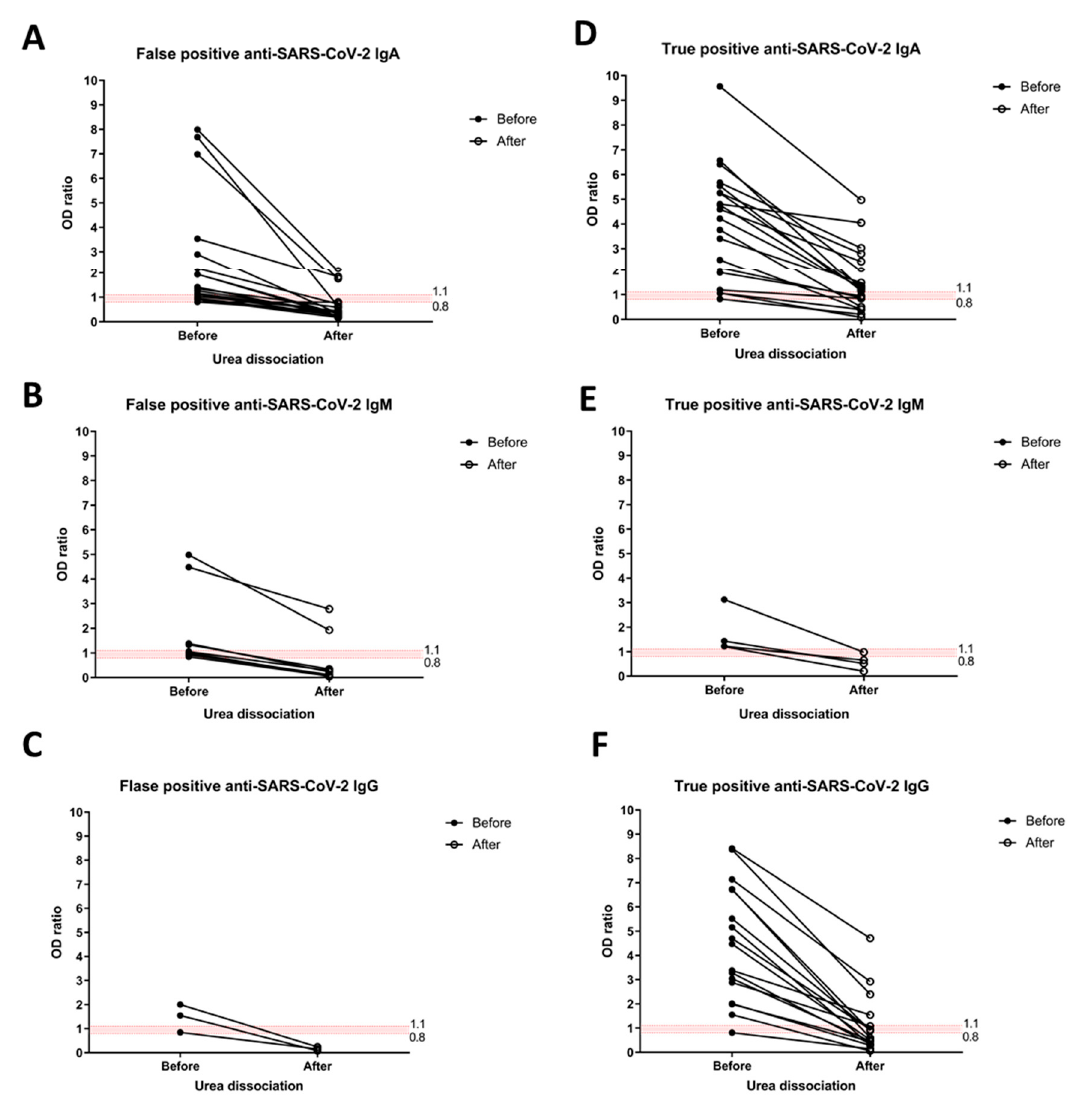
Figure 3. The anti-SARS-CoV-2 antibodies in correspondence with urea dissociation. Urea dissociation was performed with all borderline and positive results for anti-SARS-CoV-2 ELISA, both false positive ( A – C ) and true positive ( D – F ). The results of anti-SARS-CoV-2 IgA ( A , D ), IgM ( B , E ), and IgG ( C , F ) prior and subsequent to urea dissociation were plotted. An OD ratio <0.8 was considered as negative, 0.8–1.1 was considered as borderline (red horizontal area), and ≥ 1.1 was considered positive.